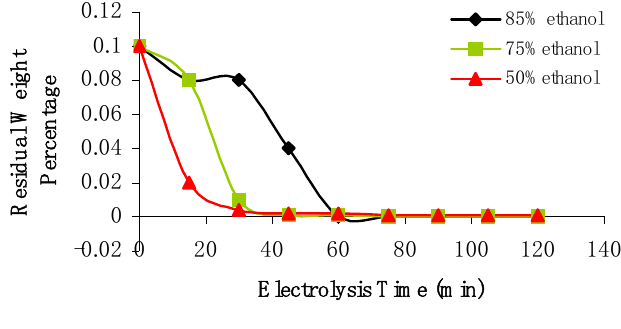
Figure 10. Plot of the residual weight percentage and electrolysis time for 0.1% w/v morin at 415, 420 nm ; ▲ ,50% ethanol, (cid:132) ,75% ethanol and (cid:139) 85% ethanolic solution (a 0.1% solution of morin in 25% ethanol cannot be